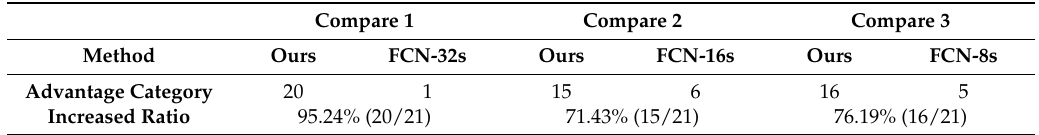
Table 4. Pair-wise comparison of IoU score.